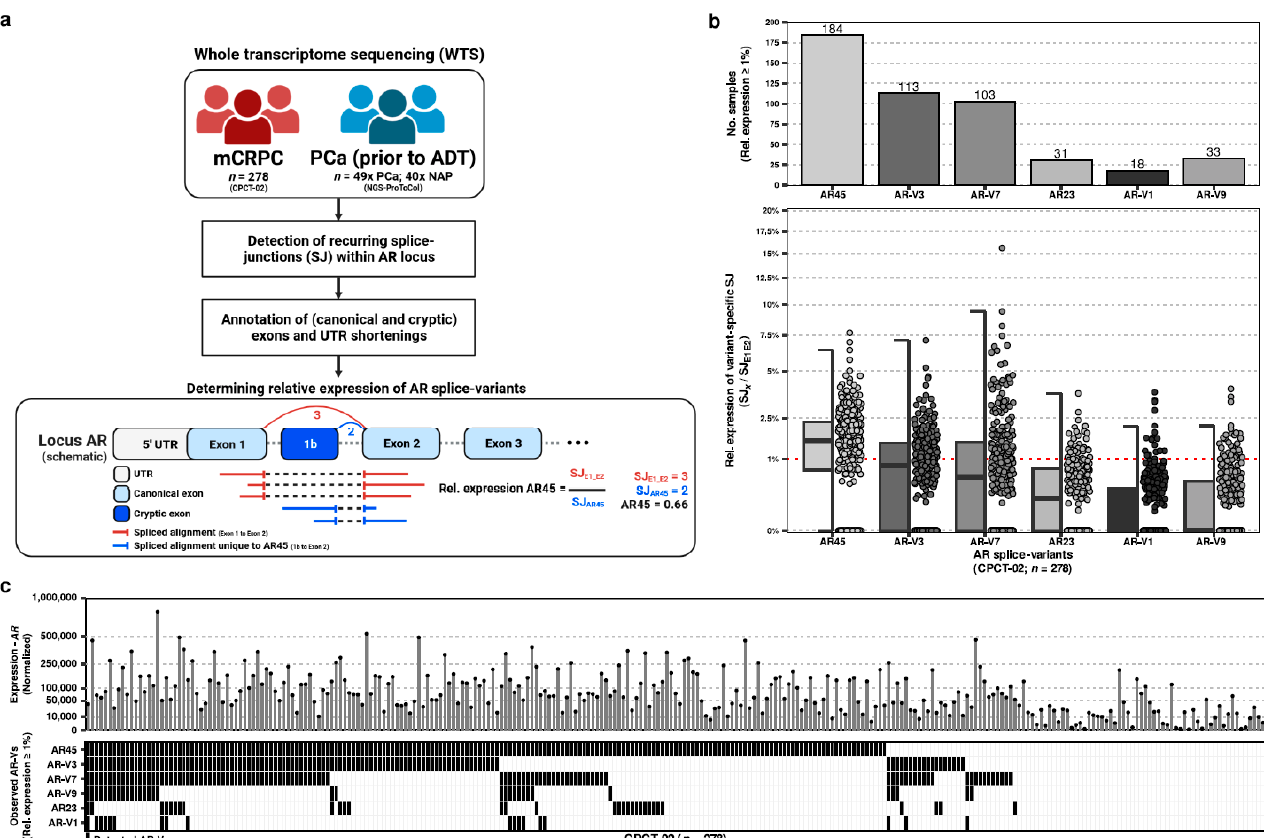
Figure 1. Overview of this study and the expression of AR-Vs in the CPCT-02 mCRPC cohort. ( a ) Schematic overview of this study and the methodology to determine expression of AR-Vs; ( b ) The top panel depicts the number of samples from the CPCT-02 ( n = 278) with relative expression of AR-V speci fi c SJ ≥ 1% (compared to canonical AR exon 1 to exon 2). The lower panel depicts the relative expression per AR-V for all CPCT-02 samples. Boxplots represent the median, fi rst, and third quan- tile whilst error bars depict the interquartile range (IQR) x.5; ( c ) Overview of expressed AR-Vs ( ≥ 1% relative expression) per sample ordered on mutual exclusivity. The top panel depicts the normalized expression of AR (all exons).